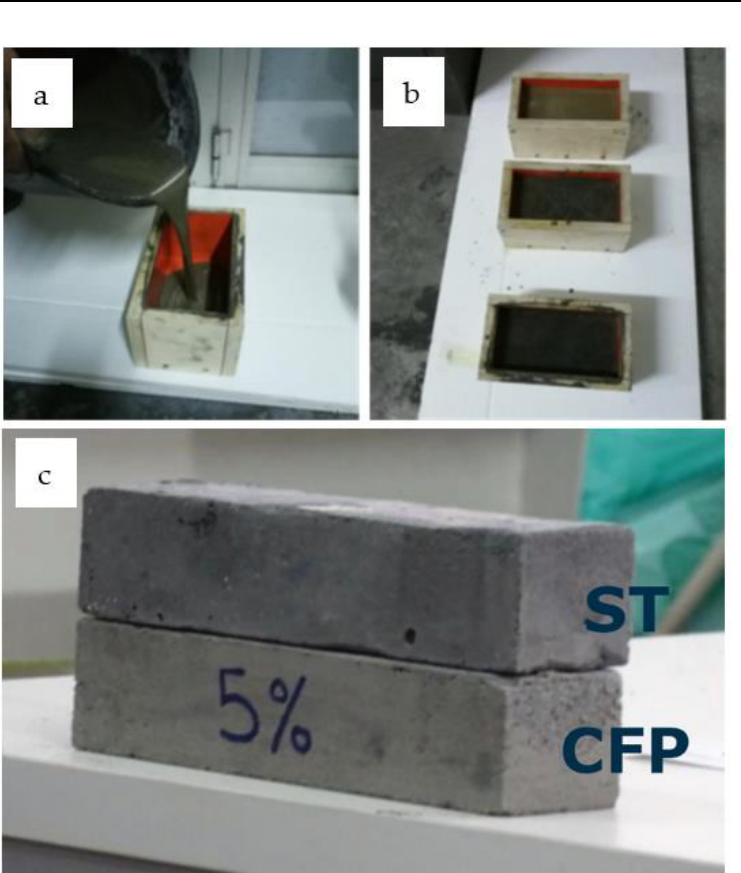
Figure 1. ( a , b ) Samples preparation and ( c ) standard and doped (ST with 5% of CFP) bentonitic grout samples.